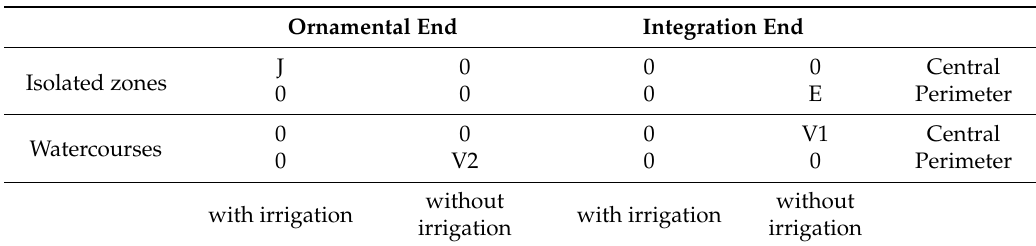
Table 1. Resulting zones and crossings between functional